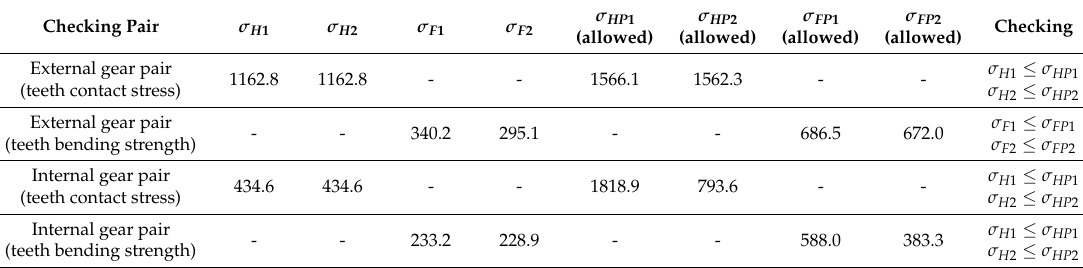
Table 8. Checking of each gear pair